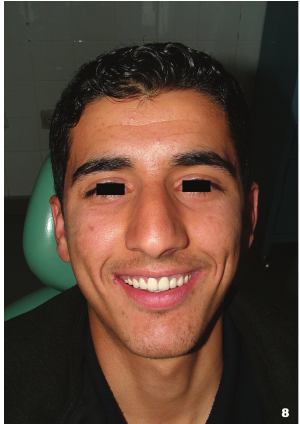
Figure 8: Facial appearance of the patient 10 months after the